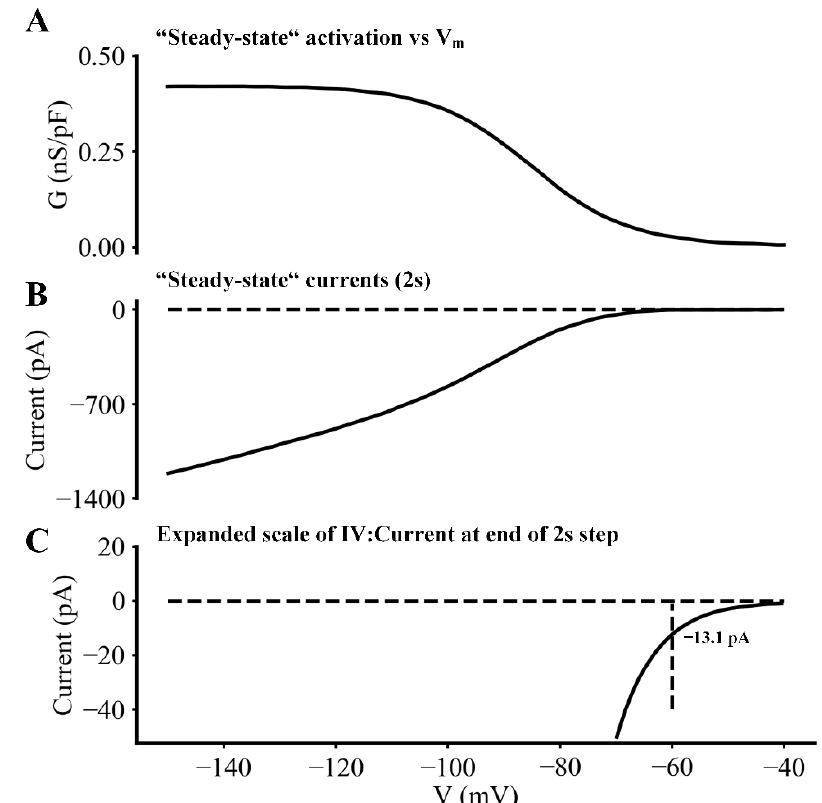
Figure 8. Current changes due to I f during the pacemaker depolarization obtained using amphotericin-mediated patch electrode recordings at 35 °C in an adult mouse SAN pacemaker myocyte. ( A ) Steady-state activation relationship for I f plotted as a function of membrane potential. ( B ) Illustration of the I f current activated by the same voltage ramp protocol described in the Legend of Figure 7. ( C ) Plot of the same data as that in ( B ), after an approximately 30-fold increase in gain. This provides an indication of the maximal I f current change in I f that can be expected to occur within the range of membrane potentials ( − 40 mV to − 70 mV). This range corresponds to the membrane potentials during the spontaneous pacemaker depolarization (see Figure 1A).